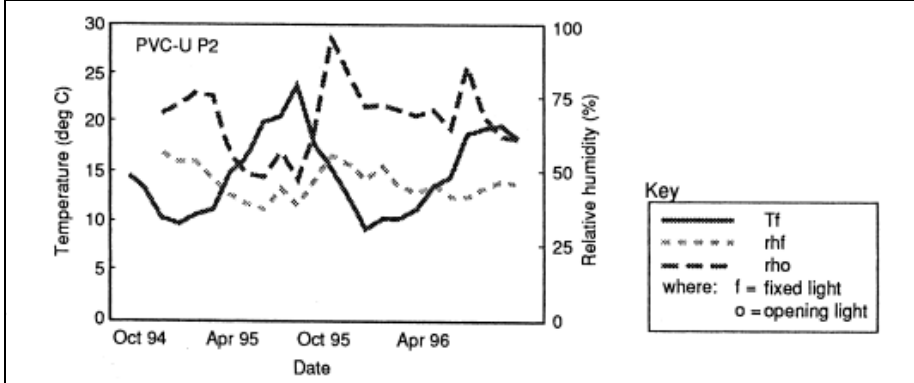
Figure 8. Mean Temperature and Relative Humidity for PVC-U P2 Type Window [15].